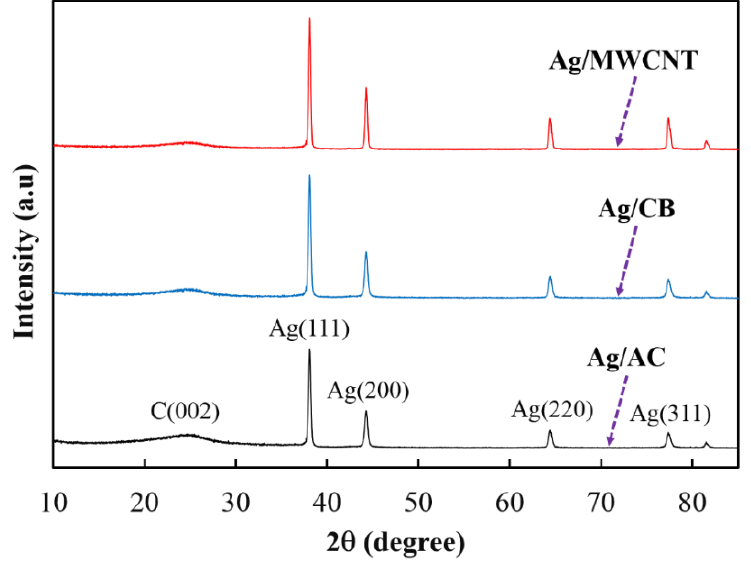
Figure 3. X-ray diffraction (XRD) spectrum patterns of the synthesized catalysts. Figure 3. X-ray di ff raction (XRD) spectrum patterns of the synthesized